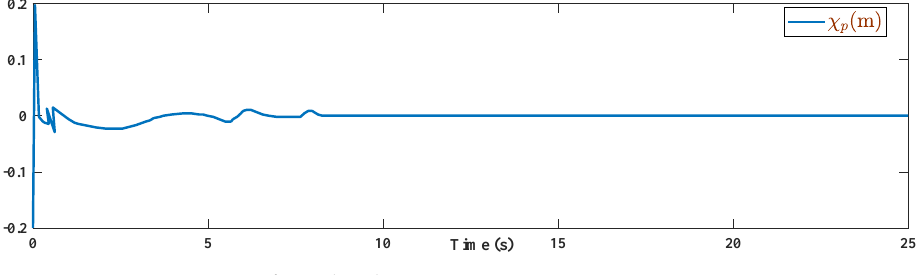
Figure 12. Time response of x p related to Scenario 2.